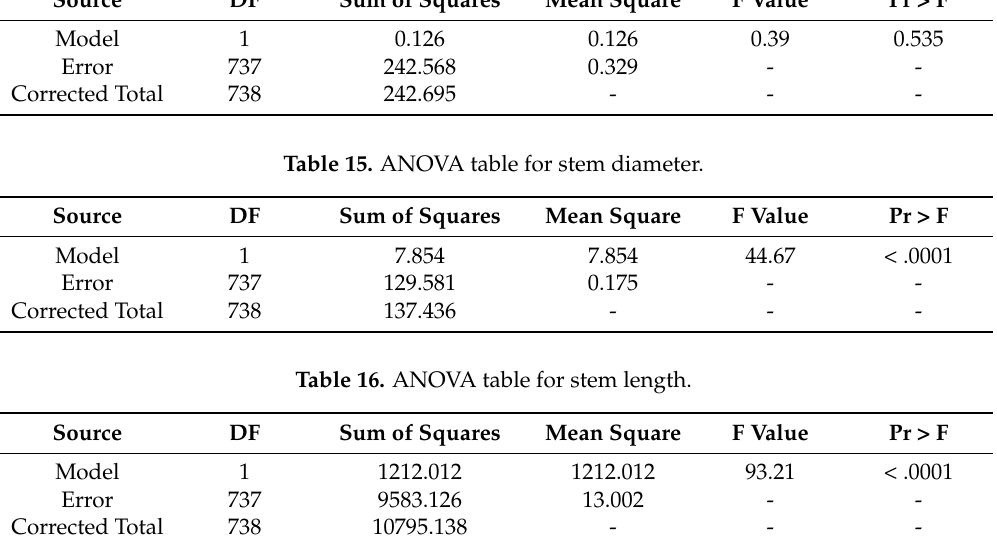
Figure 14. Factors for growth status. Table 13. The onion seedling growth states for both groups.